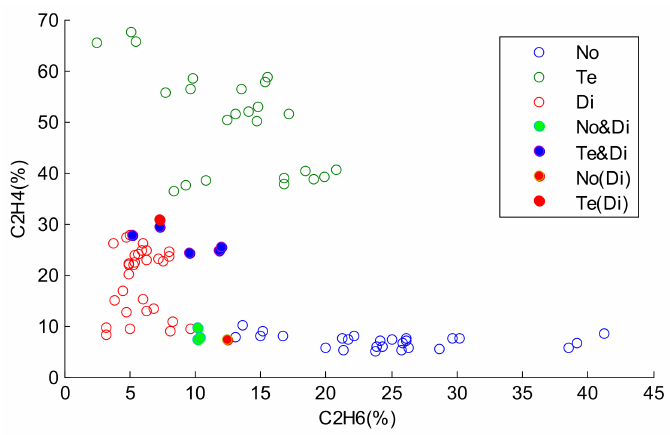
Figure 5. Classification result by our proposed method (Re = 2.22%, Ri = 8.89%).